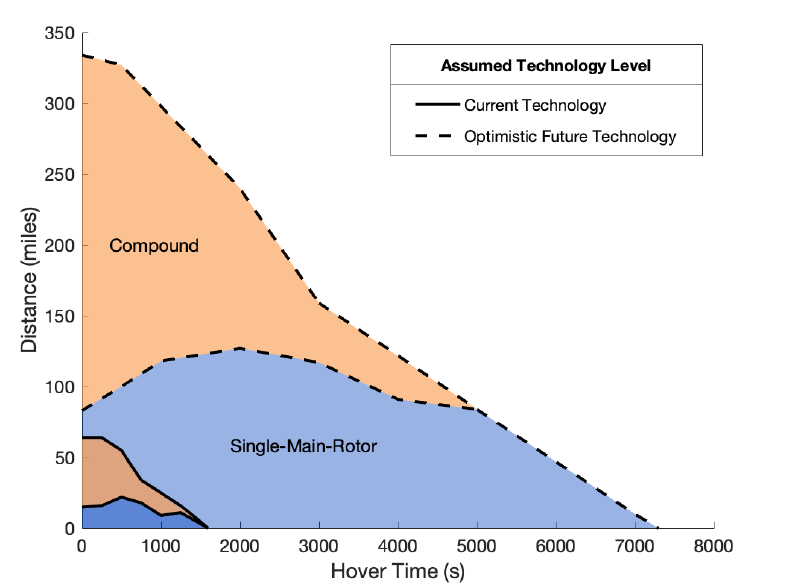
Figure 9. Feasible design space with most efficient options for a 2-passenger payload and 80 knot cruise speed assuming a decoupled